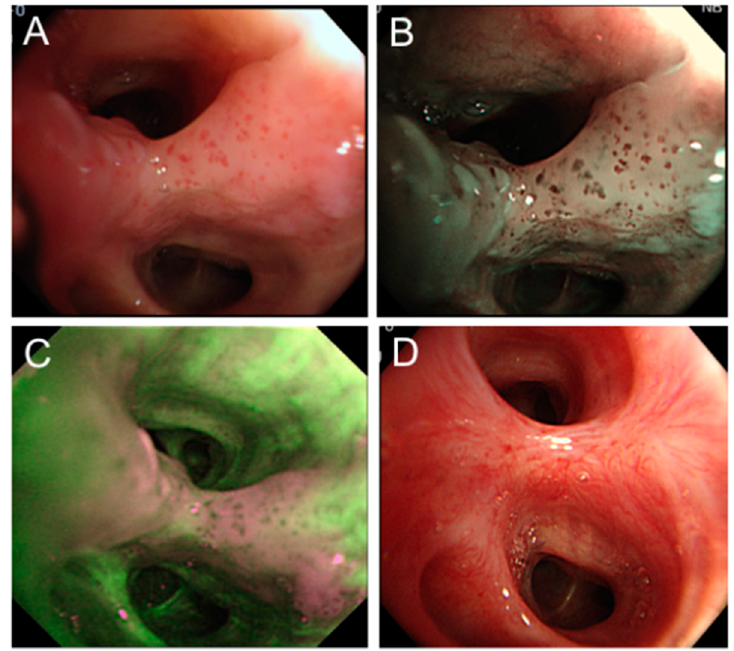
Figure 3. PDT for recurrent lung cancer. ( A ) A 70-year-old male with history of left upper lobectomy for stage IA T1aN0M0 squamous cell carcinoma. Bronchoscopy performed 10 years post resection for the investigation of abnormal sputum cytology revealed abnormal bronchial mucosa in the left lower lobe basal lateral segmental bronchus; ( B ) Narrow band imaging shows dotted vessels within the abnormal mucosa; ( C ) Autofluorescence bronchoscopy shows abnormal fluorescence in the same area; and ( D ) Follow-up bronchoscopy six months post PDT (180 J/cm 2 ) shows only scarring from the treatment with complete response.